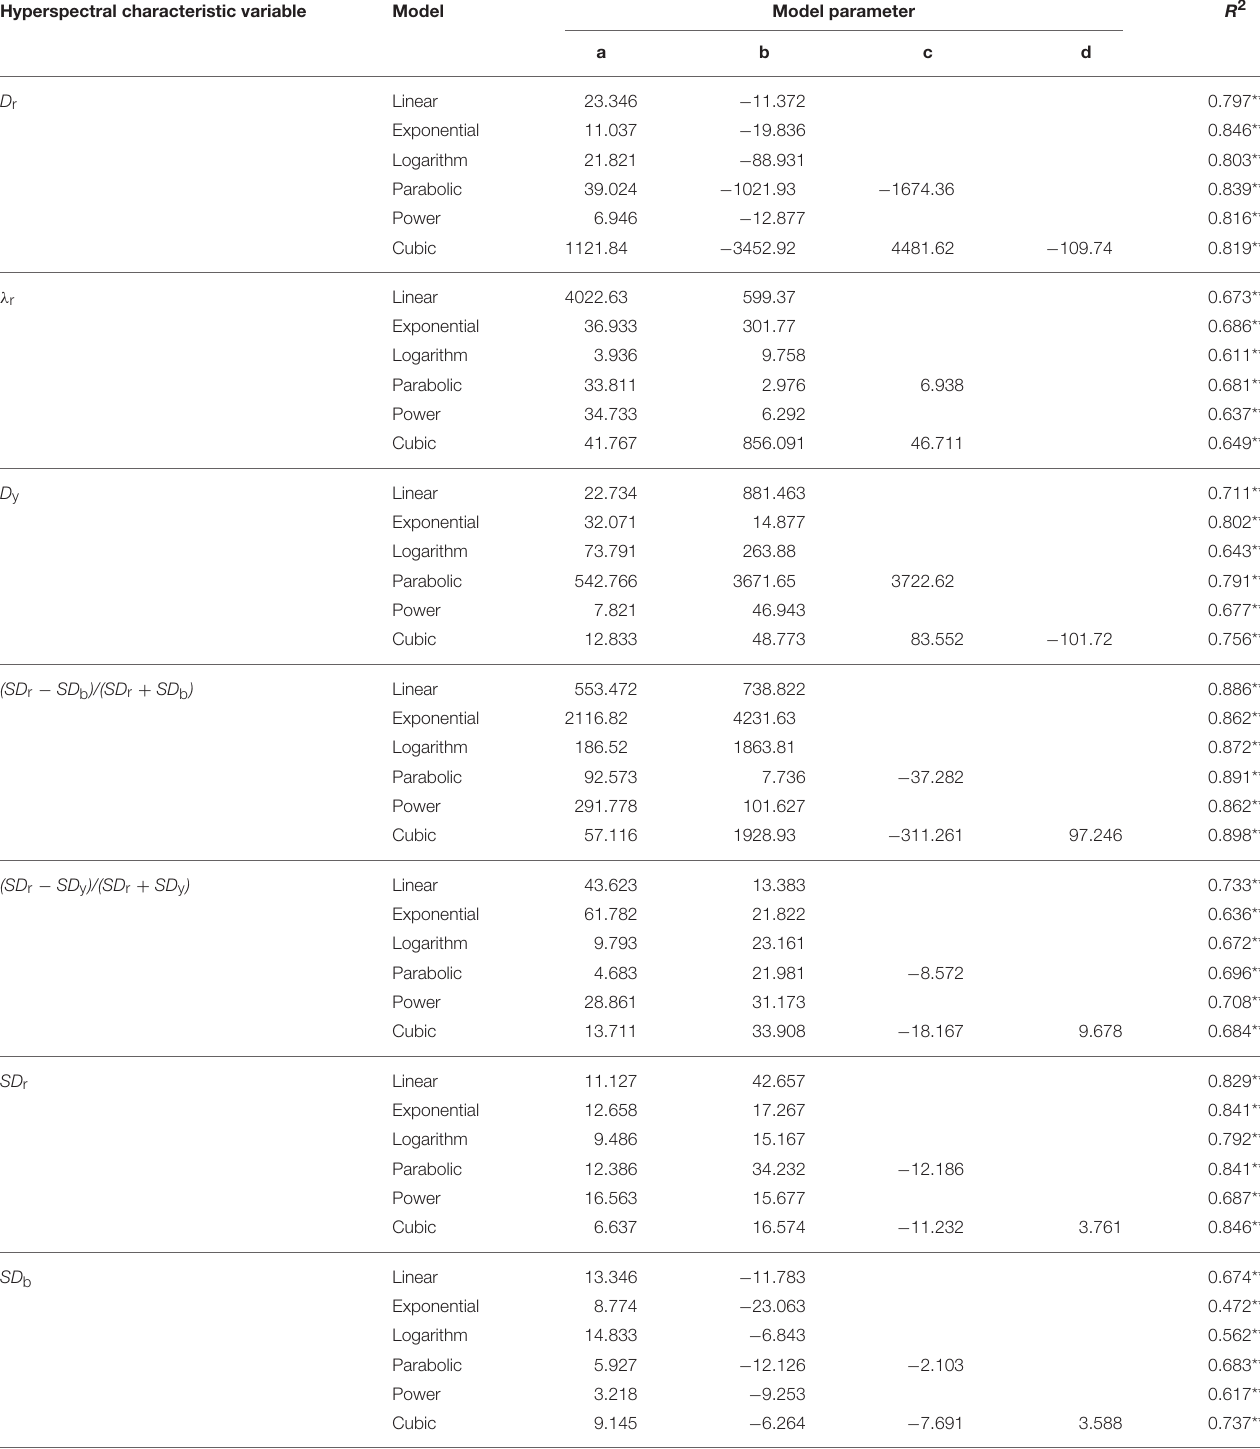
TABLE 4 | Linear and non-linear regression analysis between hyperspectral characteristic variables and wheat LNA ( n = 144). Hyperspectral characteristic